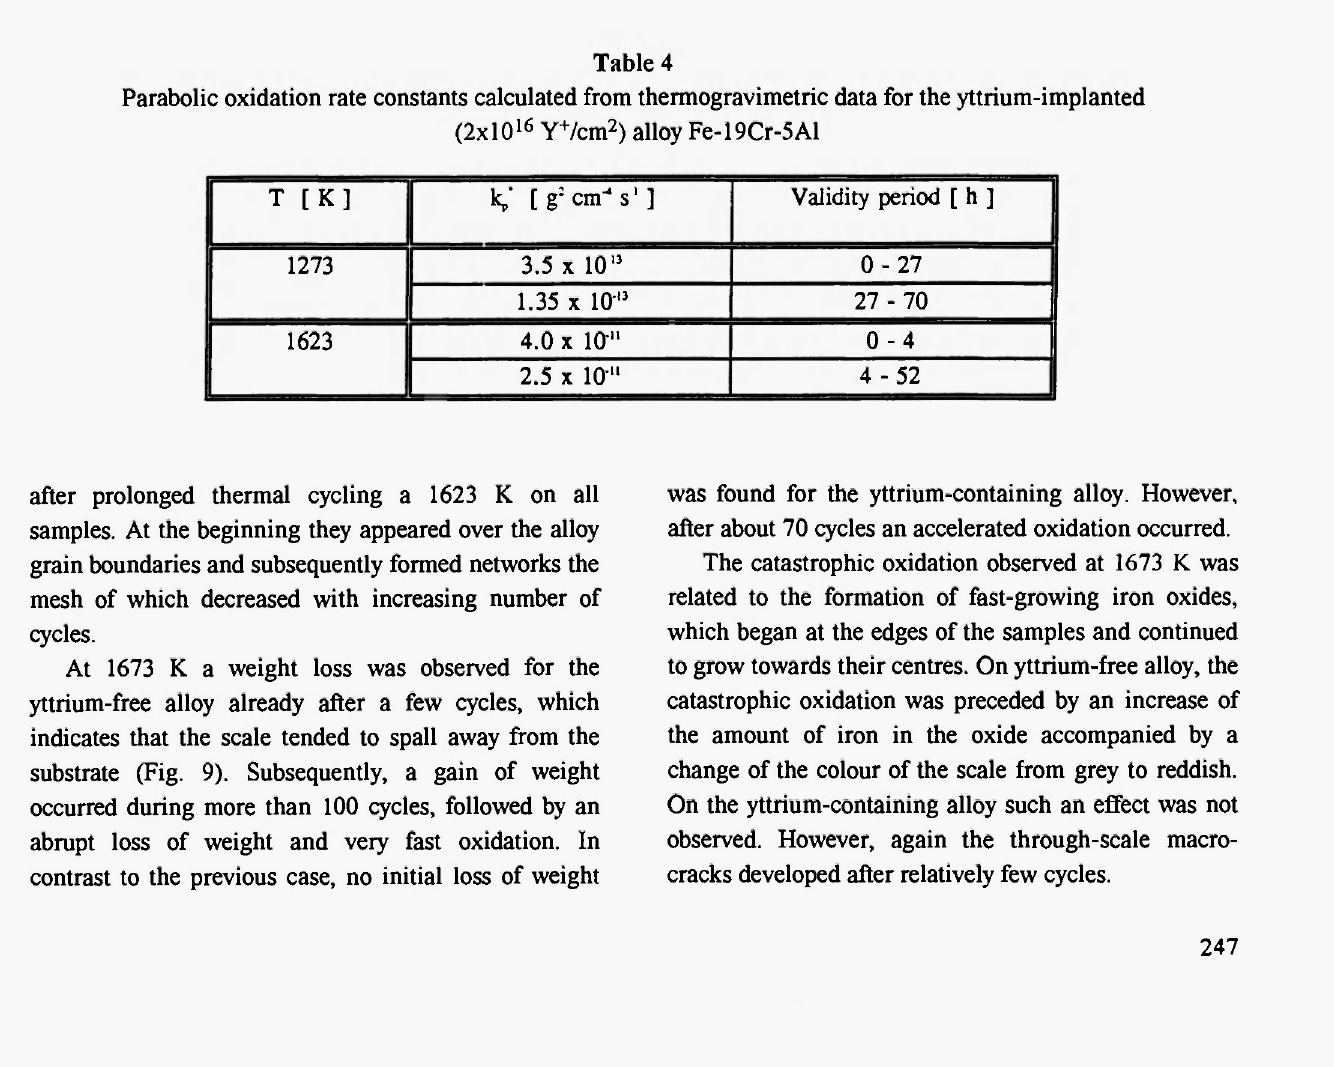
Parabolic oxidation rate constants calculated from thermogravimetric data for the